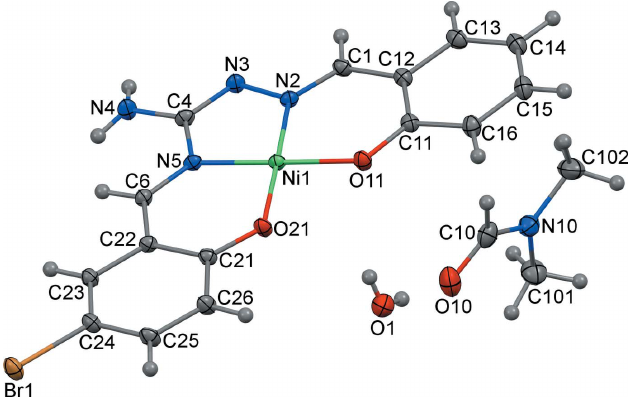
Figure 2 View of a pair of centrosymmetically related trans -oriented Ni L molecules showing the absence of (cid:3) – (cid:3) stacking.